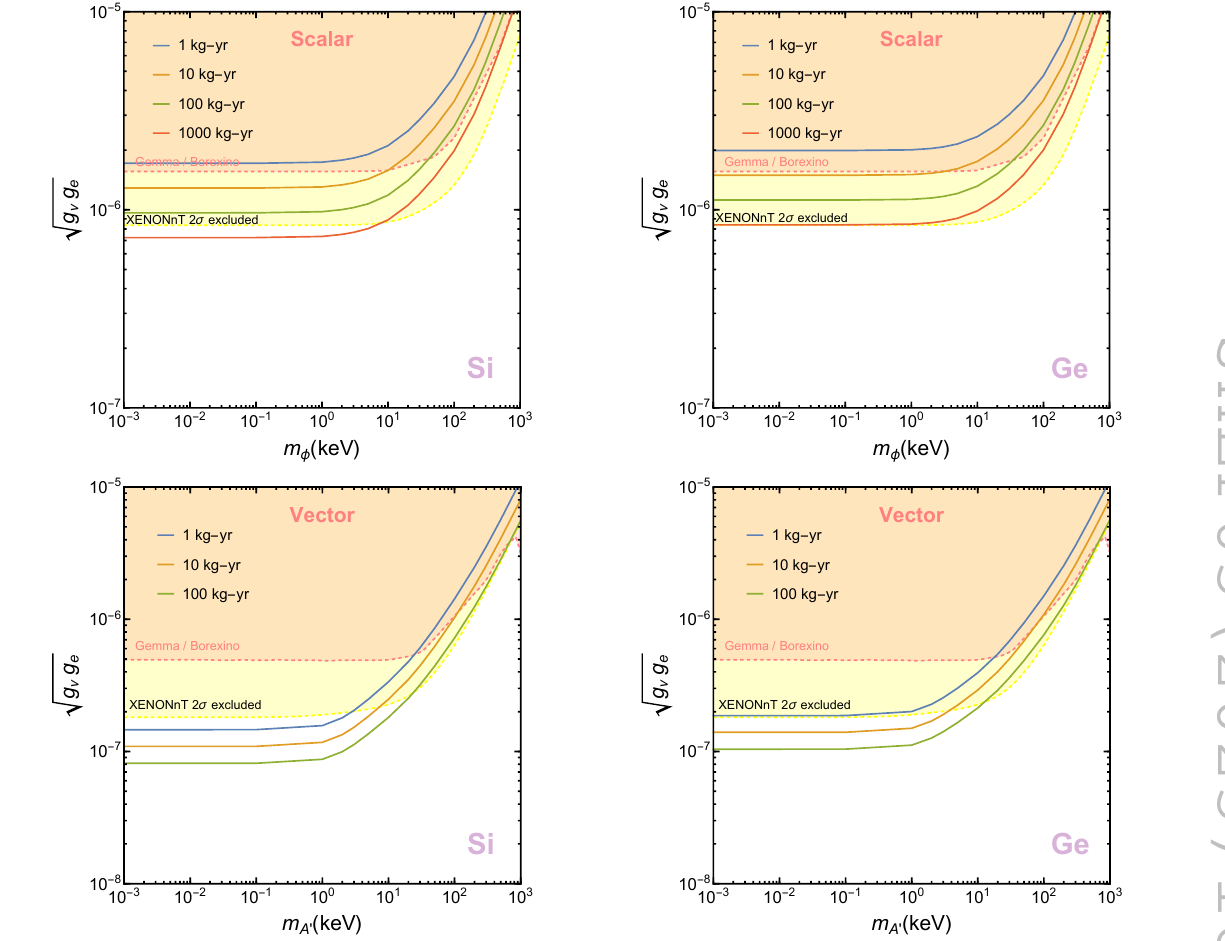
√ Figure 6 . Projected bounds on the coupling g ν g e at 90% confidence level as a function of the mediator masses assuming a constant background of 1 DRU and the detector threshold is 5 eV.. The bounds are given for four different exposure values: 1 kg-yr, 10 kg-yr, 100 kg-yr, and 1000 kg-yr for scalar mediators (top panel) for silicon (left) and germanium (right) target. For the vector mediator (bottom panel) three different exposure have been considered: 1 kg-yr, 10 kg-yr, and 100 kg-yr. The current excluded regions from XENONnT (yellow region) and Gemma/Borexino (orange region) are also